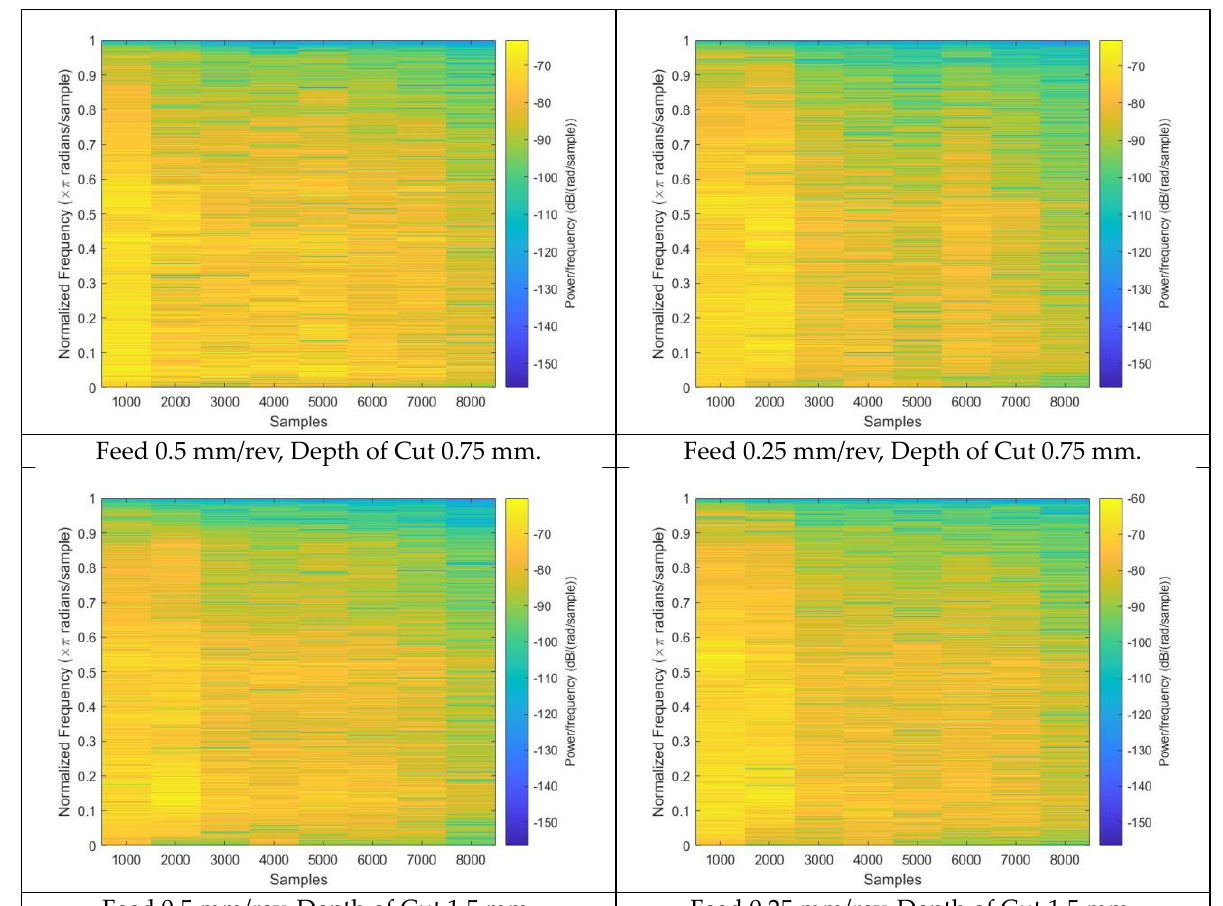
Figure 3. Scalogram generated from various milling operating conditions.